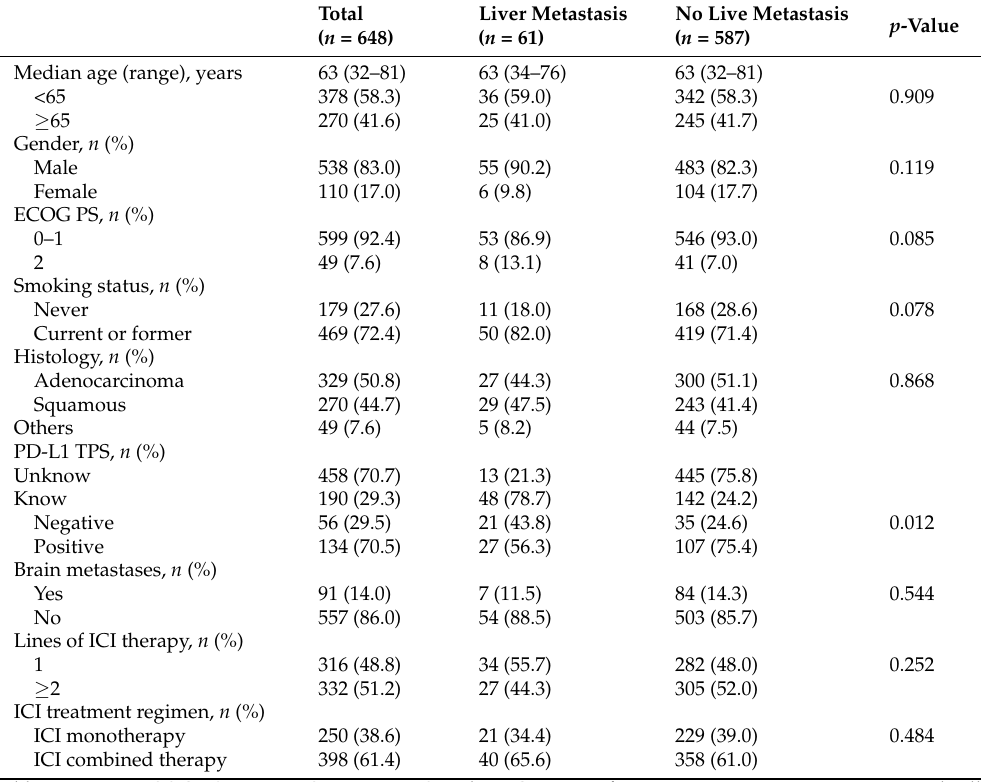
Table 1. Baseline characteristics of included NSCLC patients according to the liver metastasis